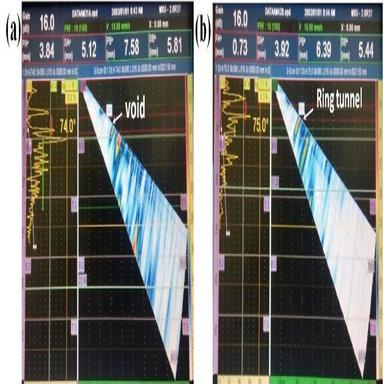
PAUT image showing (a) void (b) ring tunnel.